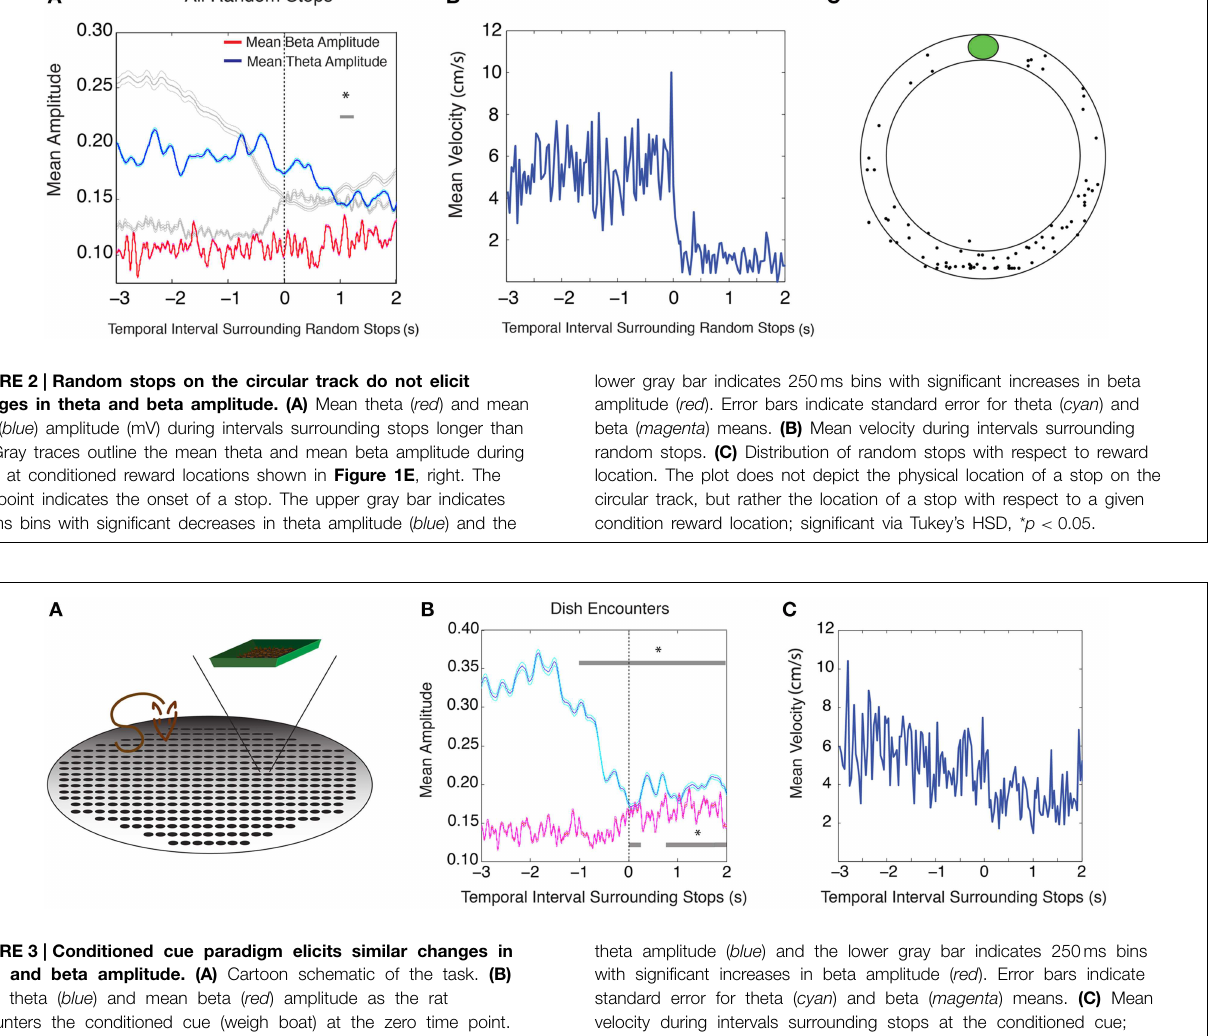
FIGURE 3 | Conditioned cue paradigm elicits similar changes in theta and beta amplitude. (A) Cartoon schematic of the task. (B) Mean theta ( blue ) and mean beta ( red ) amplitude as the rat encounters the conditioned cue (weigh boat) at the zero time point. The upper gray bar indicates 250ms bins with significant decreases in